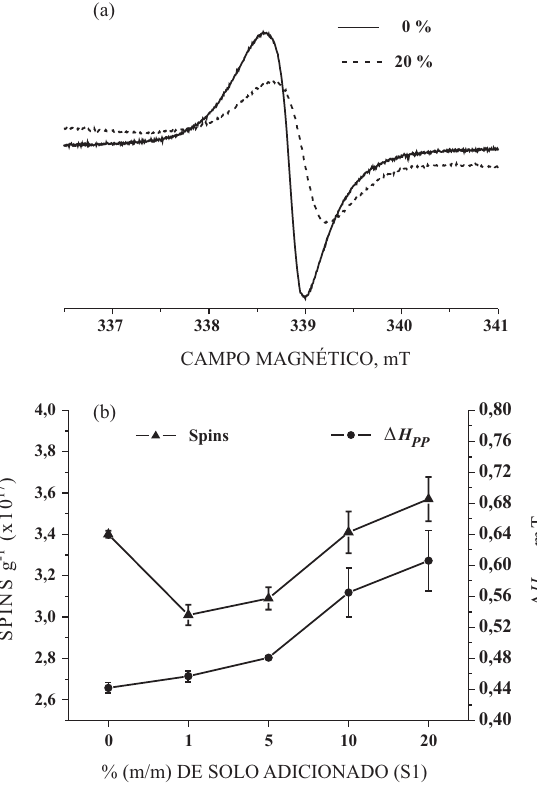
Figura 3. Espectros de RPE da amostra 6 com dife- rentes porcentagens (m/m) de solo adicionado (S1) à amostra (a). Largura de linha do sinal ( ΔΔΔΔΔ H ) de acordo com a porcentagem de S1 adi- PP cionado e concentração de RLO (em spins g -1 de amostra) considerando a porcentagem de solo adicionado (S2) à mesma amostra